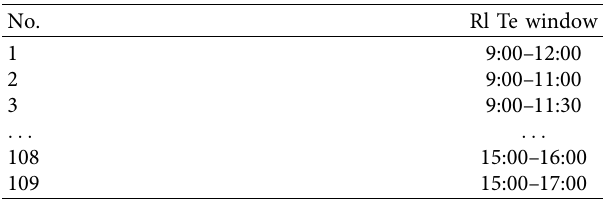
Table 4: Vacant parking spaces in Triumph Square.